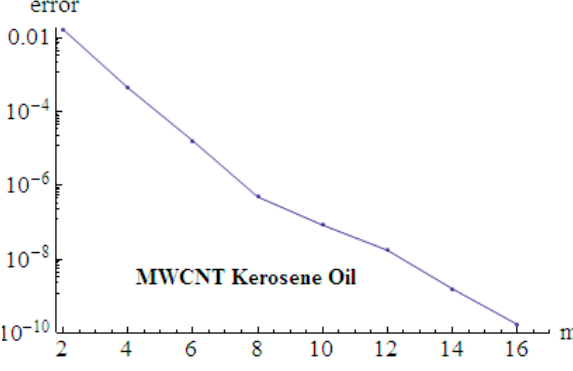
Figure 3. Total error vs. order of approximations.